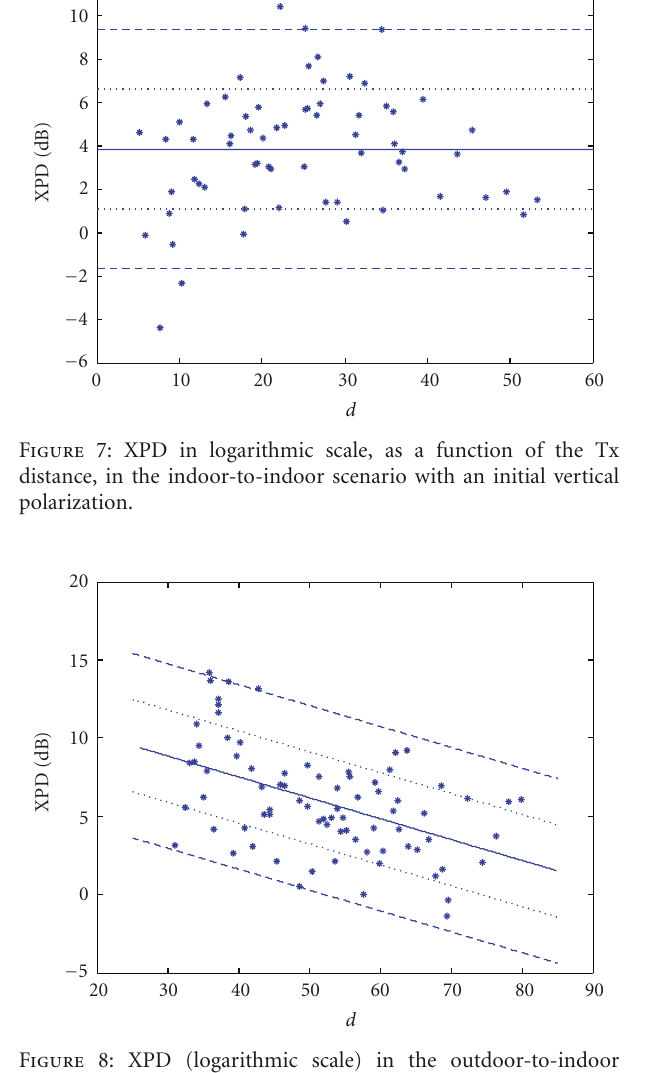
Figure 8: XPD (logarithmic scale) in the outdoor-to-indoor scenario.